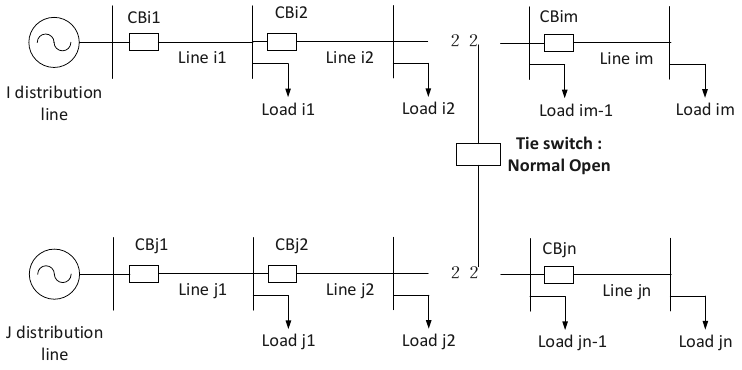
Figure 2. Open loop distribution system.